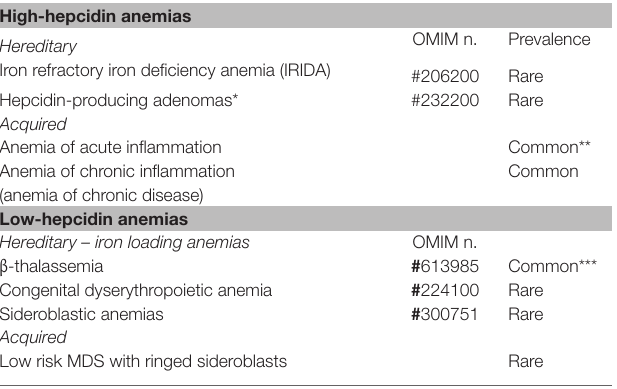
TABLE 1 | Anemias classified according to hepcidin